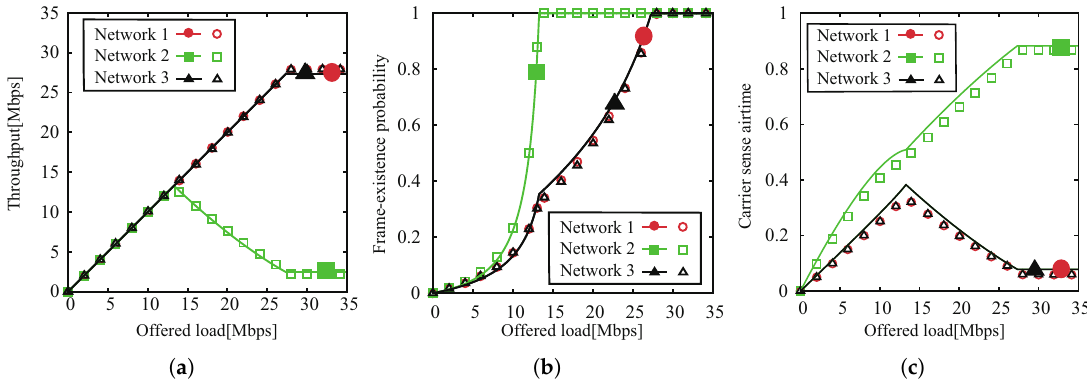
Figure 5. Network characteristics of analytical (lines) and simulation (plots) results as a function of the offered load for Scenario 1. ( a ) Throughput. ( b ) Frame-existence probability. ( c ) Carrier-sense airtime.